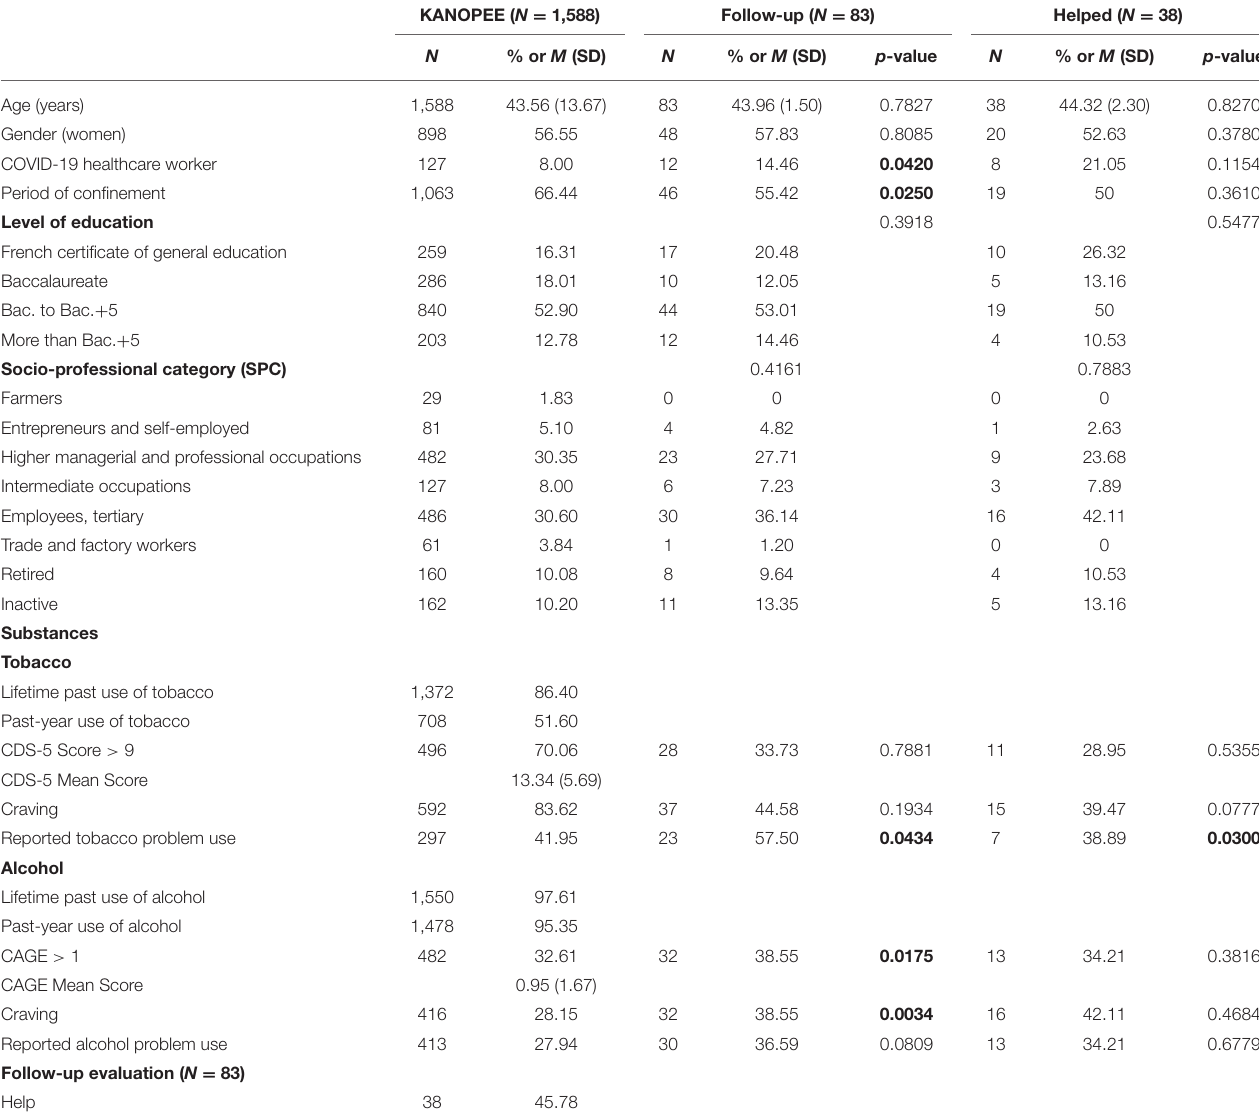
TABLE 1 | Socio-demographic, use, confinement, and evaluation characteristics of users of the KANOPEE application. KANOPEE ( N =